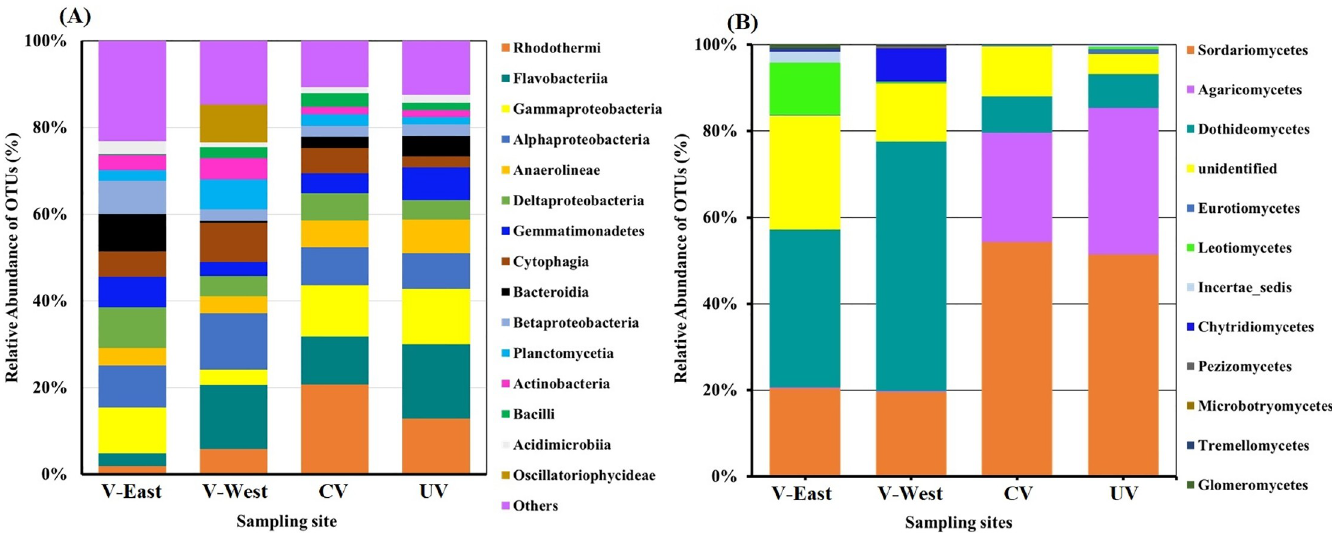
Fig 4. Mean relative abundance of the most abundant prokaryotic (A) and fungal classes ( B ) found in the peripheral vegetated, V-East and V-West sites and the central vegetated (CV) and un-vegetated (UV) zones from the central